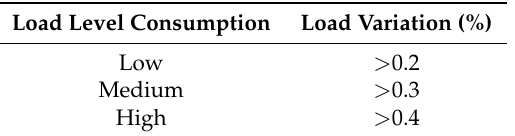
Table 6. Load level limits in single-phase.